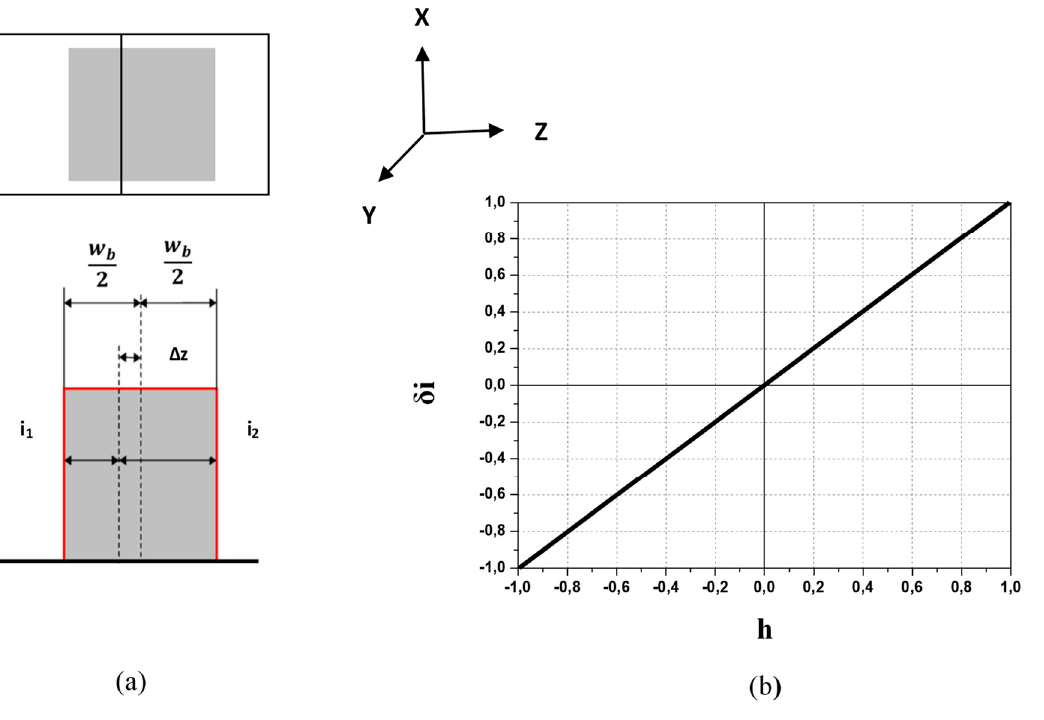
Figure 5. Schematic of split-plate detection for ideal case of uniform rectangular beam of width w b ( a ) and respective δ i I - h SPD transfer characteristic inside the dynamic range of δ i = ±1 and h = ±1 ( b ). The respective ideal secondary beam δ i I - h SPD transfer characteristic resulting